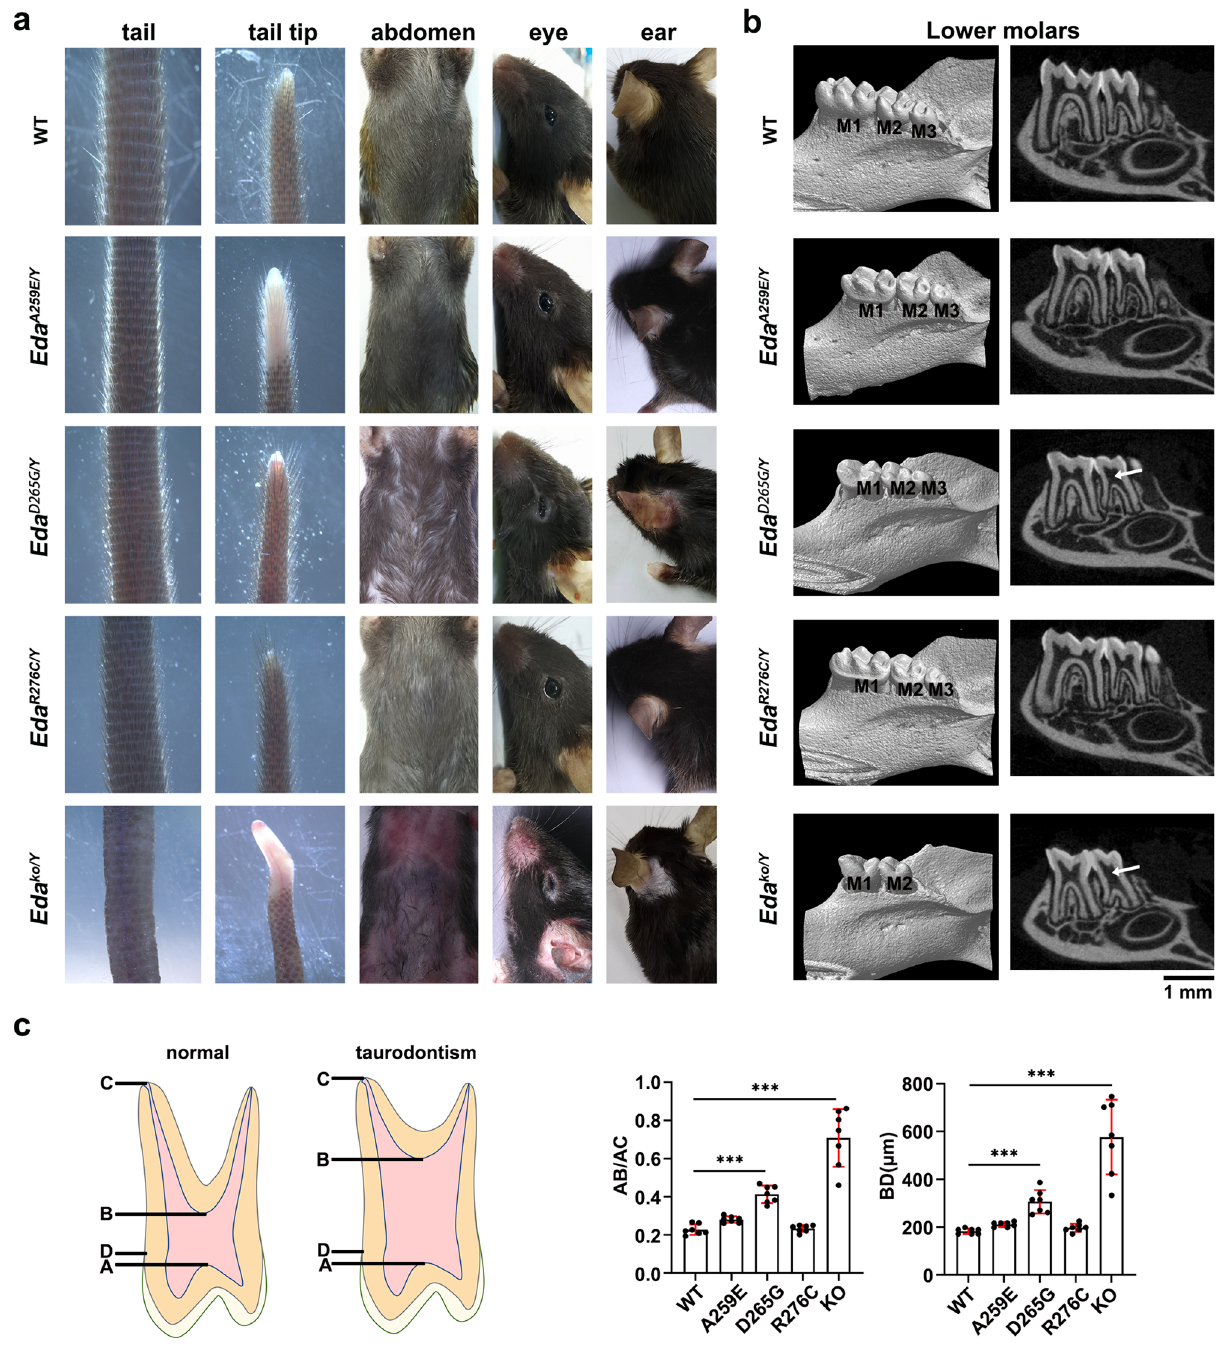
Fig. 6 | Disruption of the EDA·A1 THD -EDAR CRDS interaction results in ecto- dermal dysplasia in mice. a The Eda mutant male mice were analyzed for their ectodermal derivatives. The Eda ko/Y mice showed the most severe defects char- acterized by hairless tails and abdomen, kinked tail tips, a bald patch behind ears and abnormal eyelid development. The phenotype of the Eda D265G/Y mice was slightly milder than that of the Eda ko/Y mice, showing scanty abdomen hair and ear hair, but with normal tail hair and tips. The Eda A259E/Y and Eda R276C/Y mutant mice exhibited no obvious abnormalities in the ectodermal derivatives mentioned above. b RepresentativeradiographicimagesoflowermolarsfromWTandmutant Eda mice.Whitearrowsindicate “ bull-shaped ” taurodontismteethwithalargepulp